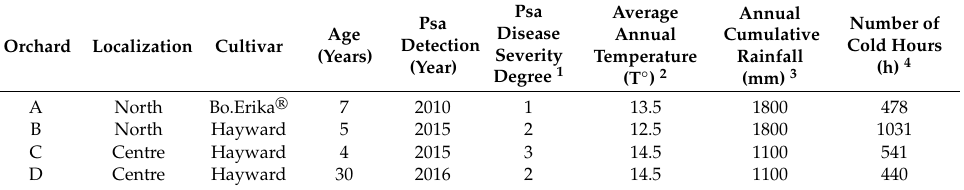
Table 1. Characteristics and climatic conditions of the studied Portuguese kiwifruit orchards.